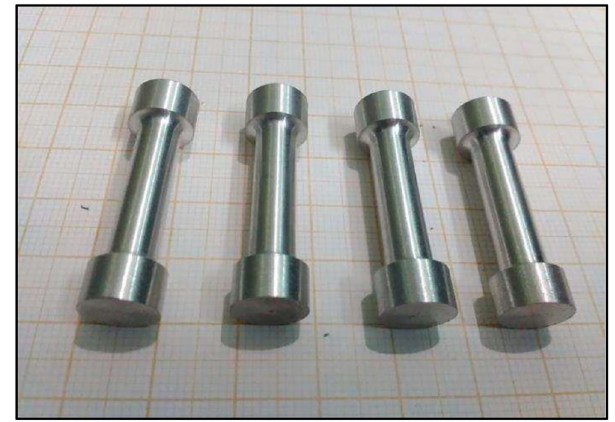
Fig. 12. Tensile specimens.